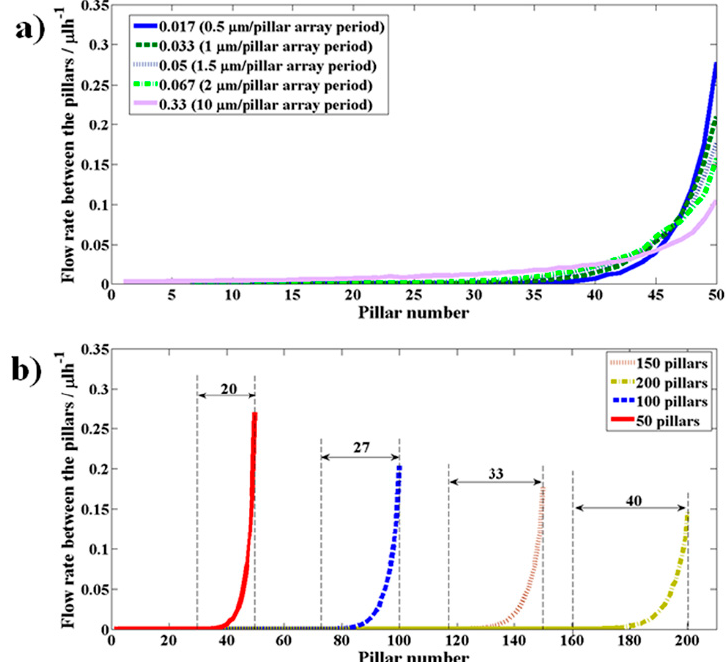
Figure 7. The variation of the flow rate across the pillar gaps, plotted as a function of the pillar number, when the slope of the side channel S slp ( a ) and number of pillars ( N) ( b ) are varied .